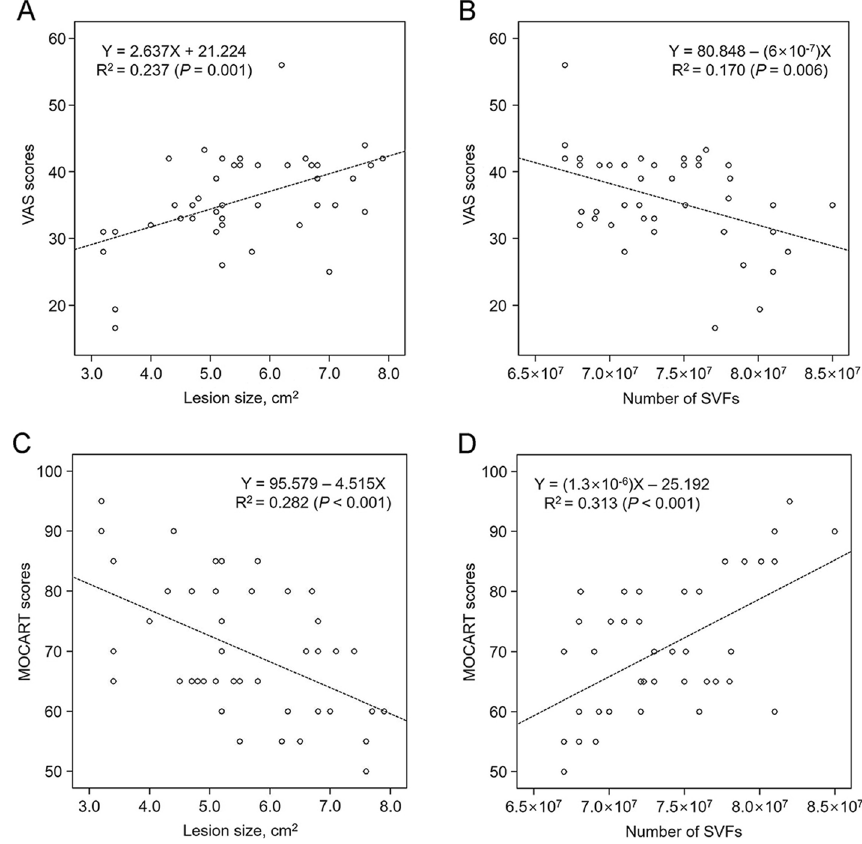
Fig. 2 Correlations between the A , B 12-month visual analogue scale (VAS) and C , D magnetic resonance observation of cartilage repair tissue (MOCART) scores and the A , C lesion size and B , D the number of stromal vascular fraction (SVF)